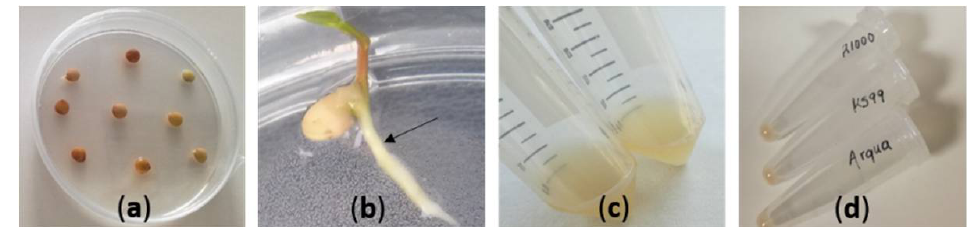
Figure 1. Agrobacterium rhizogenes -mediated transformation of lentil. ( a ) Sterilized seeds allowed to germinate; ( b ) three-day-old seedlings used as explants for hairy root induction. The arrow indicates the hypocotyl region, where sectioning was conducted and the existing roots were excised; ( c ) A. rhizogenes cultures; ( d ) inoculum used for plant transformation.